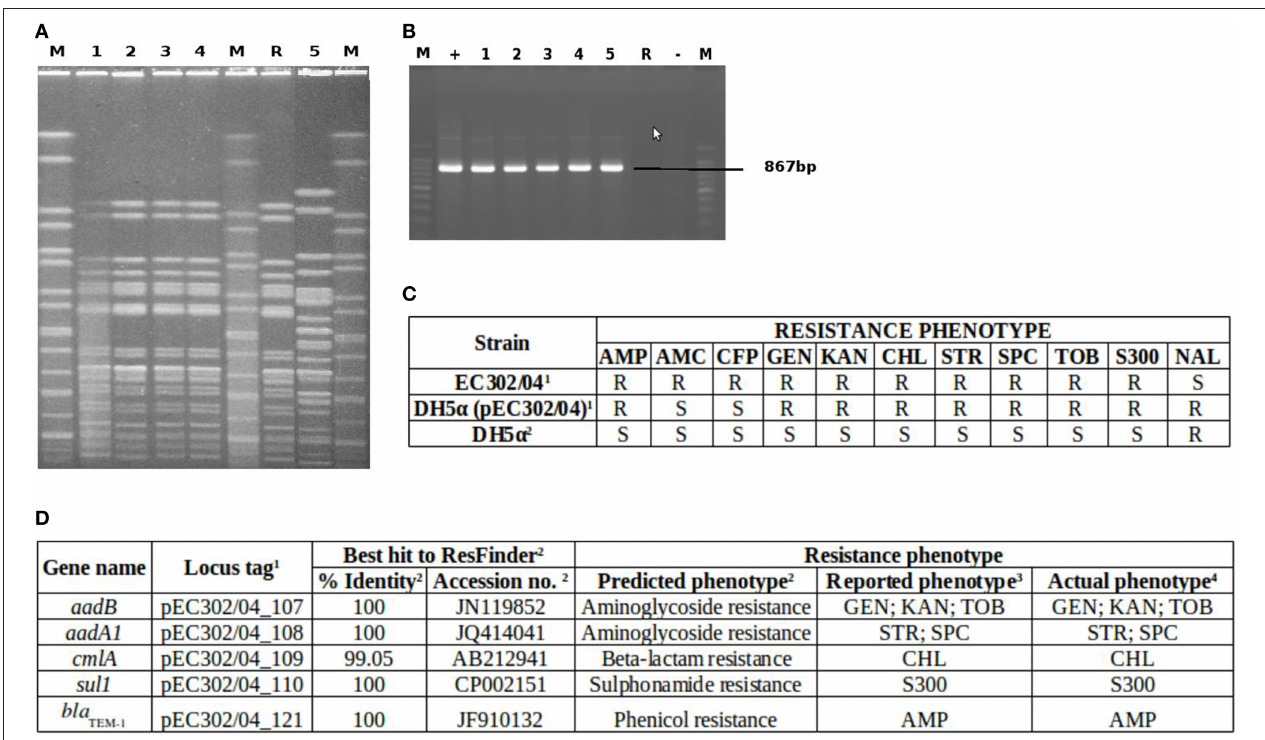
FIGURE 2 | Confirmation of pEC302/04 transfer and resistance phenotypes and genotypes of EC302/04, E. coli DH5 α and DH5 α (pEC302/04) transconjugant. (A) PFGE gel of DH5 α (pEC302/04) transconjugants, E. coli DH5 α and EC302/04. Lane M, XbaI digested H9812 DNA marker; Lanes 1–4, DH5 α (pEC302/04); Lane R, E. coli DH5 α ; Lane 5, EC302/04. (B) bla TEM detection in transconjugants DH5 α (pEC302/04), DH5 α and EC302/04. Lane M, 100bp ladder; Lane + , positive control strain EC1003-1; Lane 1–4, DH5 α (pEC302/04); Lane 5, EC302/04; Lane R, E. coli DH5 α ; Lane − , no-template (negative) control (C)